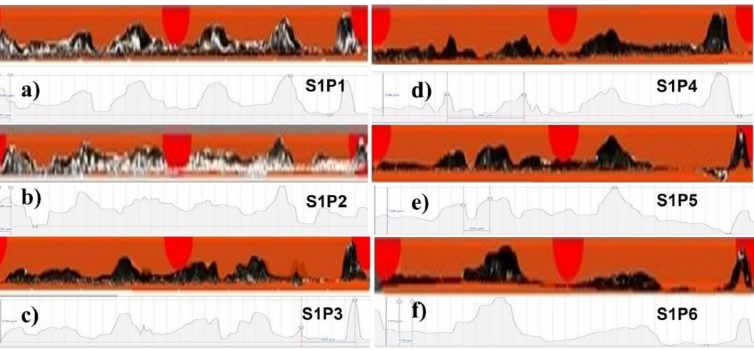
Figure 16. Peripheral morphology of ( a ) S1P1, ( b ) S1P2, ( c ) S1P3, ( d ) S1P4, ( e ) S1P5, and ( f ) S1P6.